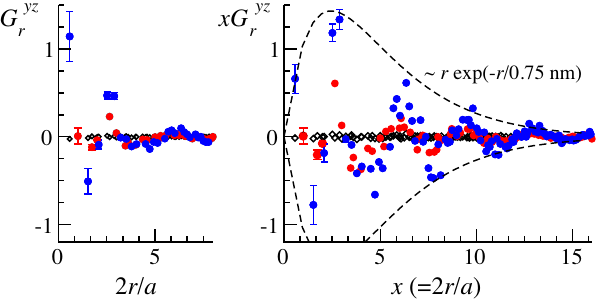
FIG. 5. Chiral spin correlations. Left: chiral correlation function G yz r as obtained by Fourier analysis. Cycloidal correlations G yz y; r of 3 f symmetry including the triangular site (blue) are dominant with respect to cycloidal correlations between only kagome sites (red). Helical correlations G yz x; r are negligible (black). Right: G yz r scaled with distance to show the extent of observable correlations and compared to an asymptotically exponential decaying